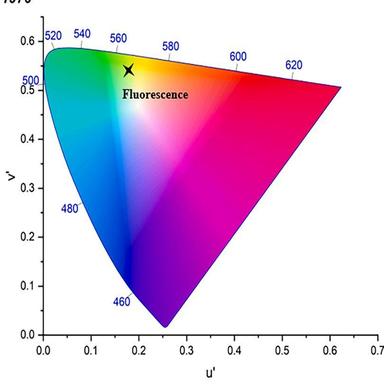
Chromaticity diagram of (C8H12N)42.